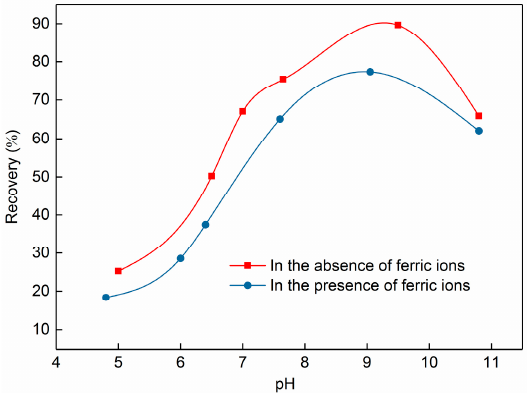
Figure 11. Flotation recovery of celestite as a function of pH, (ferric ion: 5 × 10 − 5 mol/dm 3 , NaOL: 5 × 10 − 5 mol/dm 3 ).